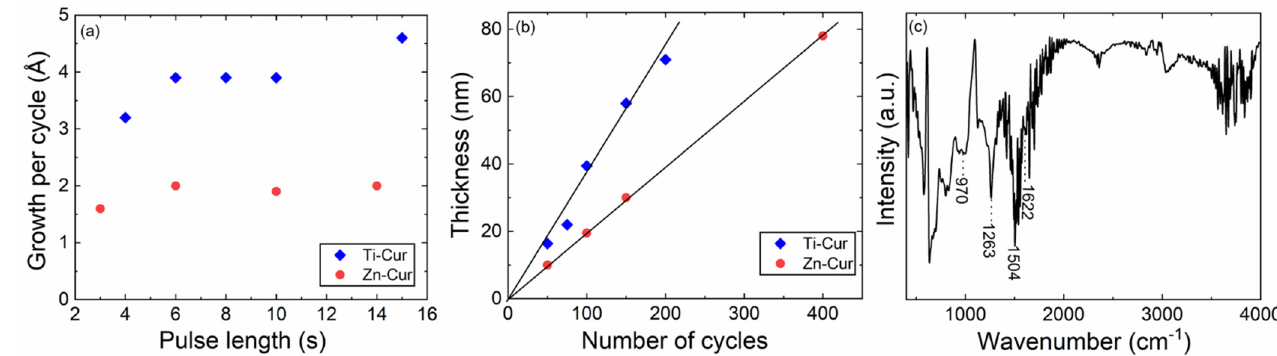
Figure 3. Characteristics of the ALD/MLD process of DEZ + Cur (in comparison to TTIP + Cur [30]) and the resultant Zn-Cur films: ( a ) Growth per cycle versus Cur pulse length; ( b ) Film thickness versus number of cycles; ( c ) FTIR spectrum for Zn-Cur film.